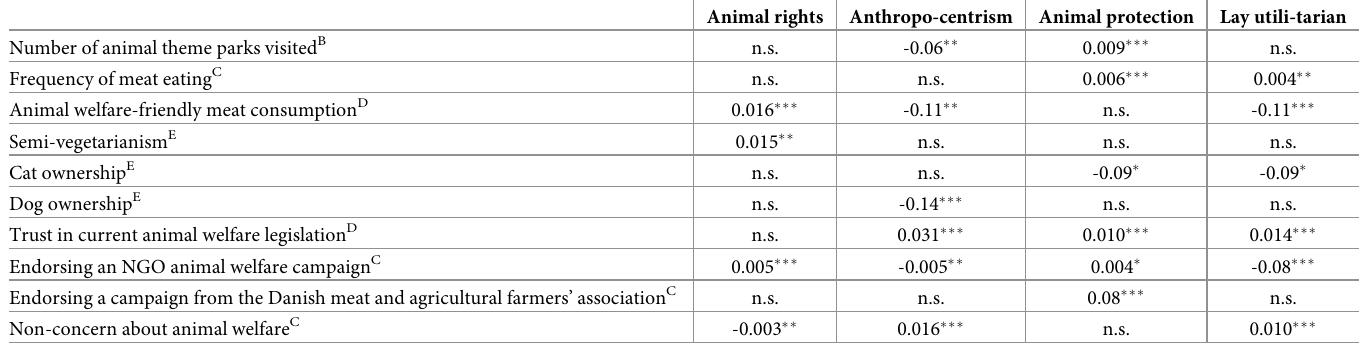
Table 4. Adjusted associations between animal ethics orientations and stated behaviour in areas where animals are used, having a cat or dog, and animal-related opinions and trust (N = 974–1002)–coefficients from multivariate models A